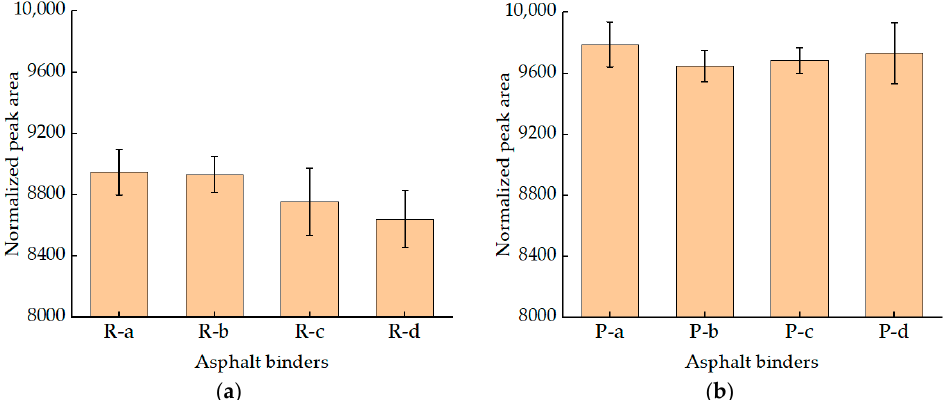
Figure 5. The NPA of aged SBS asphalt binders. ( a ) The NPA of RTFOT SBS asphalt binders; ( b ) The NPA of PAV SBS asphalt binders.